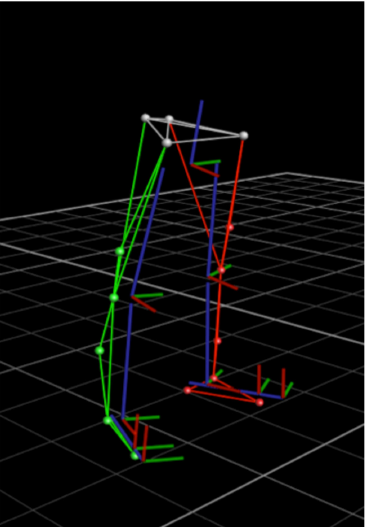
Figure 8. Subject lower limb skeleton model from 3DGA